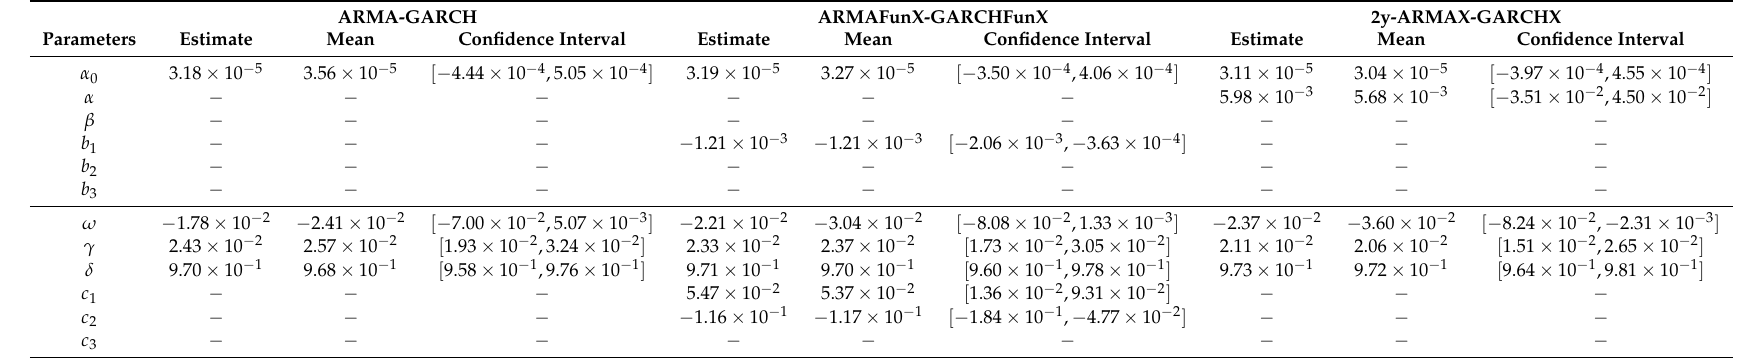
Table 2. Parameter estimates, bootstrapped means and bootstrapped 95%-confidence intervals using 10,000 simulated paths of length 2903 restricting the models from Table 1 to significant parameters